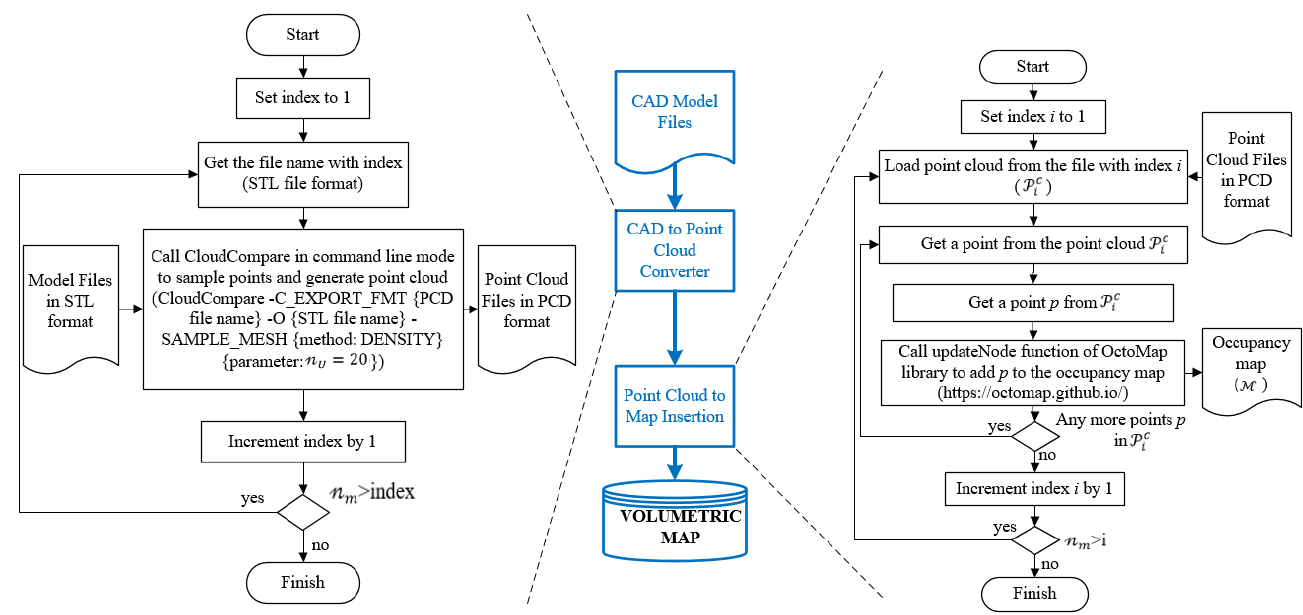
Figure 11. Flow diagram for mapping by CAD models.